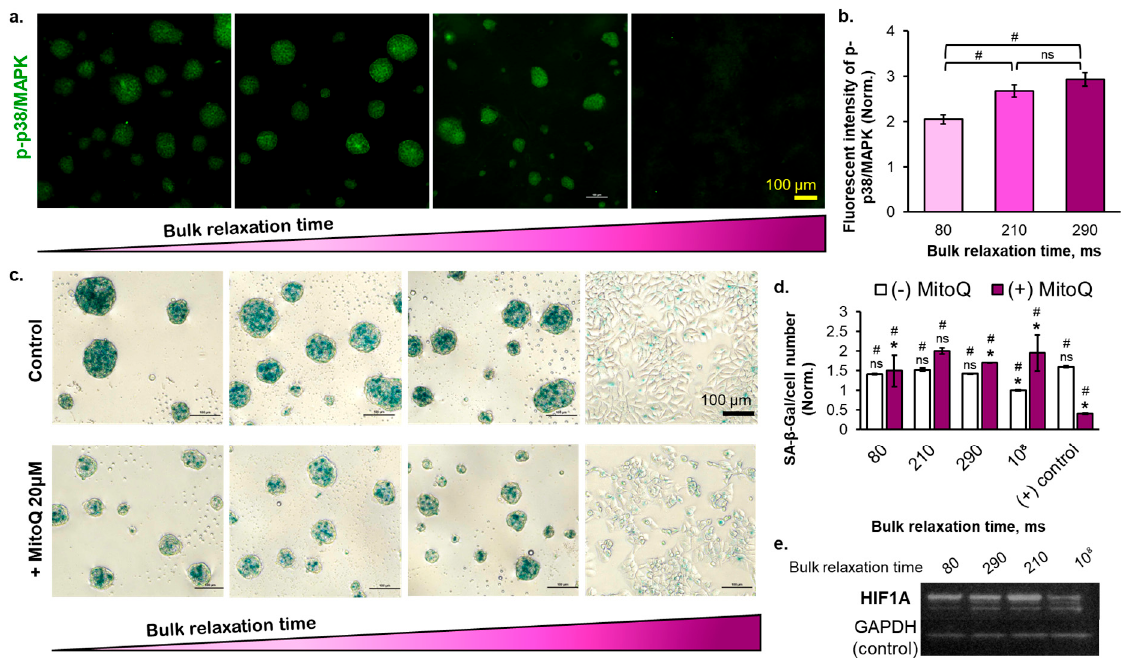
Figure 5. ( a ) The immunofluorescence staining images of the phosphorylated p38/MAPK on day 5, ( b ) the quantified expression of phosphorylated p38/MAPK based on its immunofluorescence images, ( c ) the expression of chromogenic senescence marker (SA- β -Gal) of untreated and ROS inhibitor (MitoQ) treated cells after day 5 of cell culture with scale bar= 100 µ m, ( d ) the quantified SA- β -Gal before and after ROS inhibition with MitoQ, and ( e ) the western blot image of the HIF1A protein at day 5. (Statistical analyses: Student’s t -test ns p > 0.05; # is the comparison between drug-treated and untreated p < 0.05; * is the comparison between different samples p <